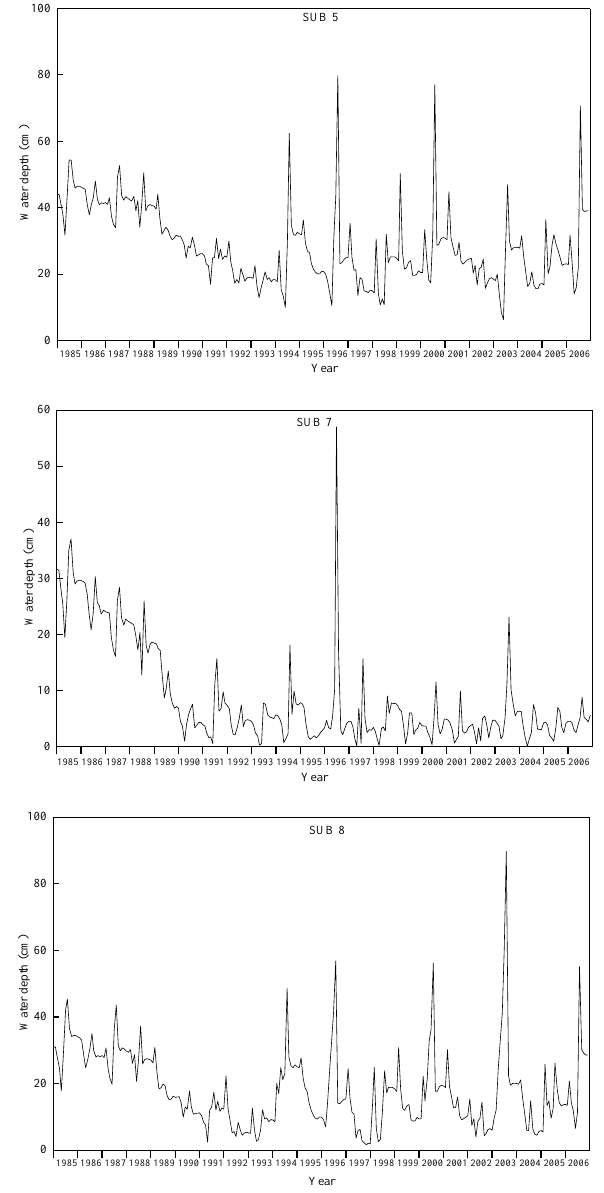
Fig. 10. Simulated surface water depth in different subbasins of central zone in the Zhalong Wetland, Northeast China, for 1985 and 2006.